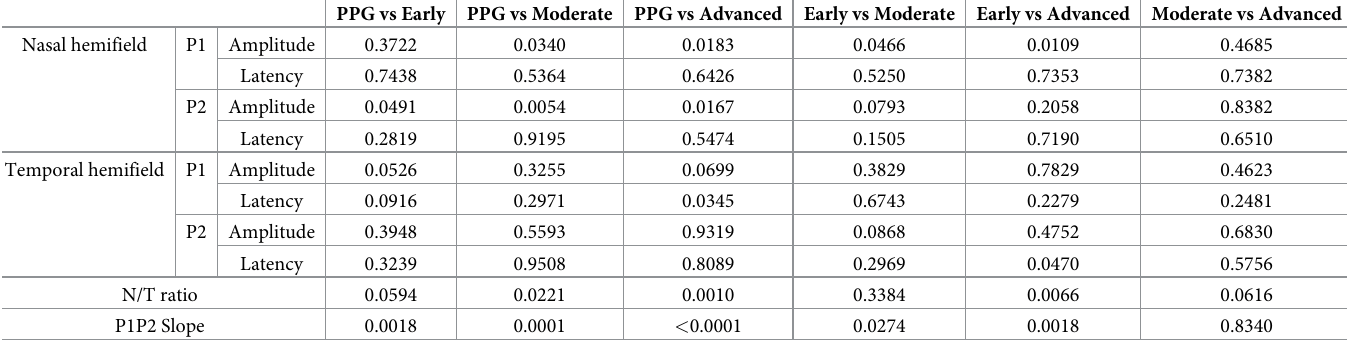
Table 3. Comparisons of mfERG parameters between the